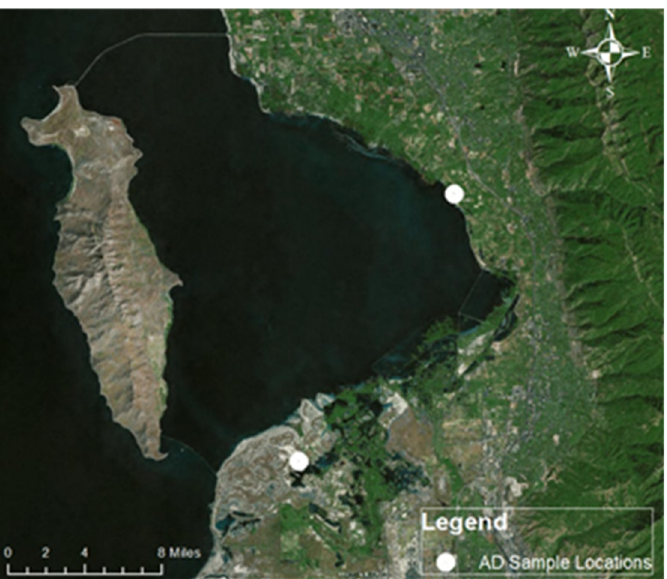
Figure 3. Field locations that had side-by-side sample tables at ~1 m and ~2 m heights. These sample locations are near Farmington Bay on the Great Salt Lake approximately 50 km north of Utah Lake.